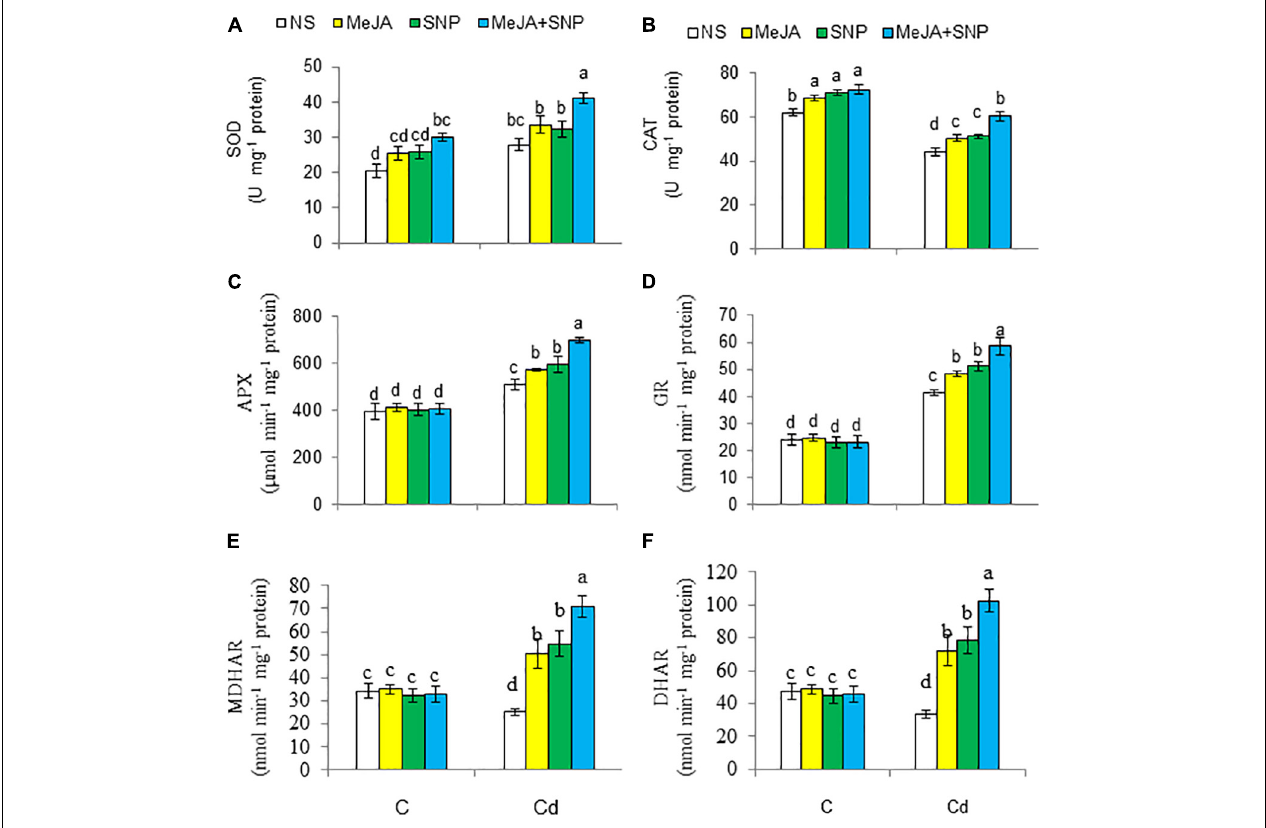
FIGURE 7 | Activities of superoxide dismutase [SOD (A) ], catalase [CAT (B) ], ascorbate peroxidase [APX (C) ], glutathione reductase [GR (D) ], monodehydroascorbate reductase [MDHAR (E) ], and dehydroascorbate reductase [DHAR (F) ] in wheat plants grown under control (C) and cadmium (100 µ M